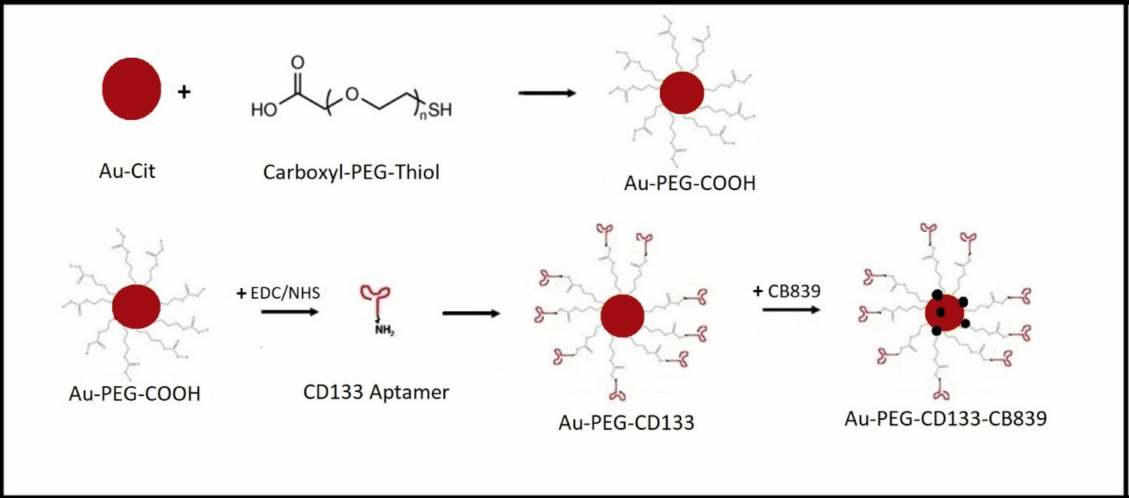
Figure 9. Schematic overview of nanoparticle